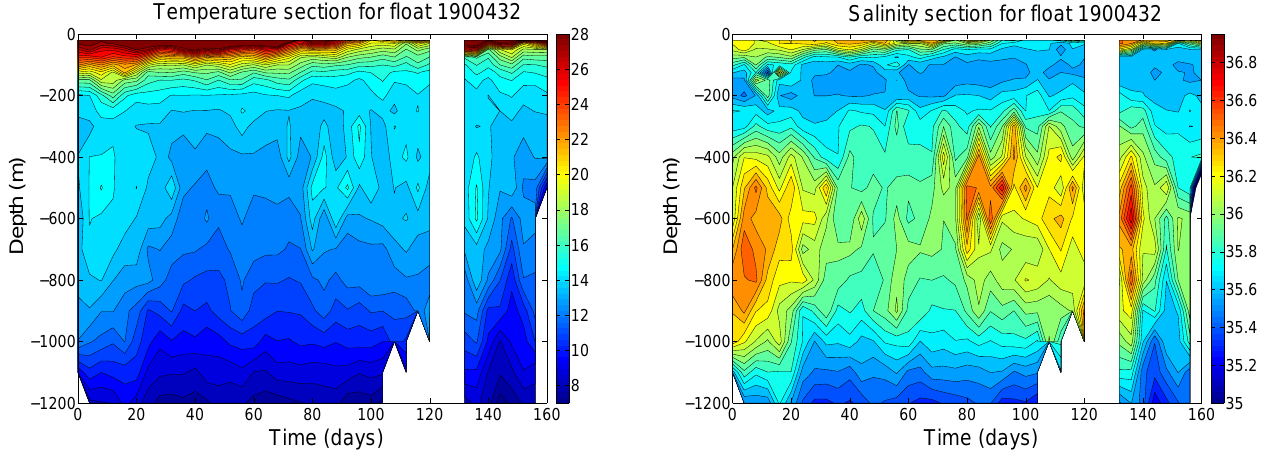
Fig. 5. (Left) Vertical section of temperature (in ◦ C) along the trajectory of float 1900432 in the Gulf of Aden; (right) vertical section of Figure 5: (Left) Vertical section of temperature (in o C ) along the trajectory of float salinity. 1900432 in the Gulf of Aden; (right) vertical section of salinity